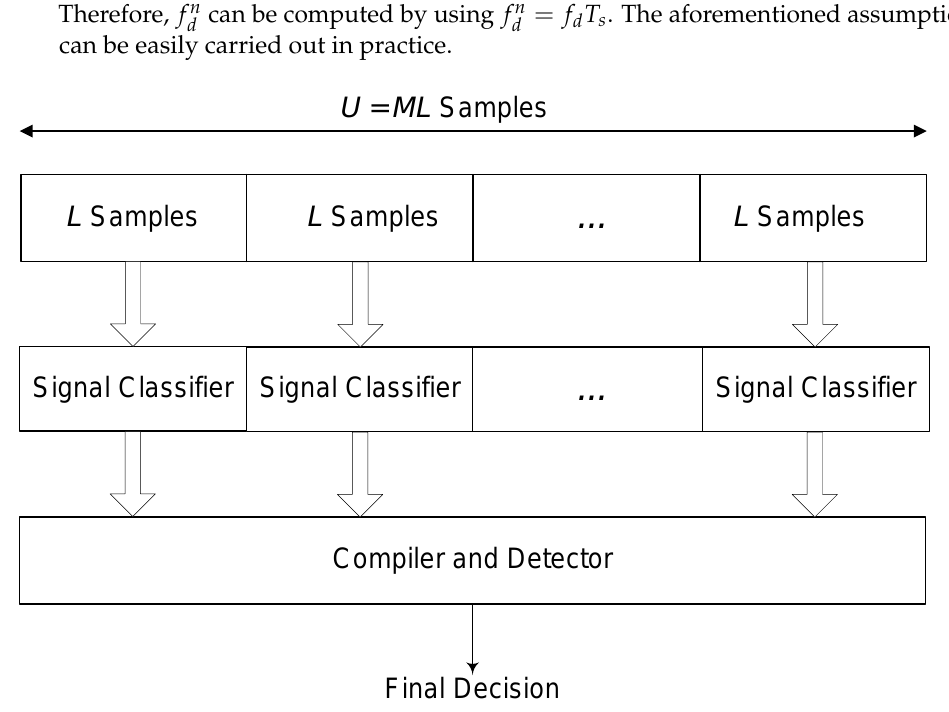
Figure 2. Conceptual block diagram of the proposed